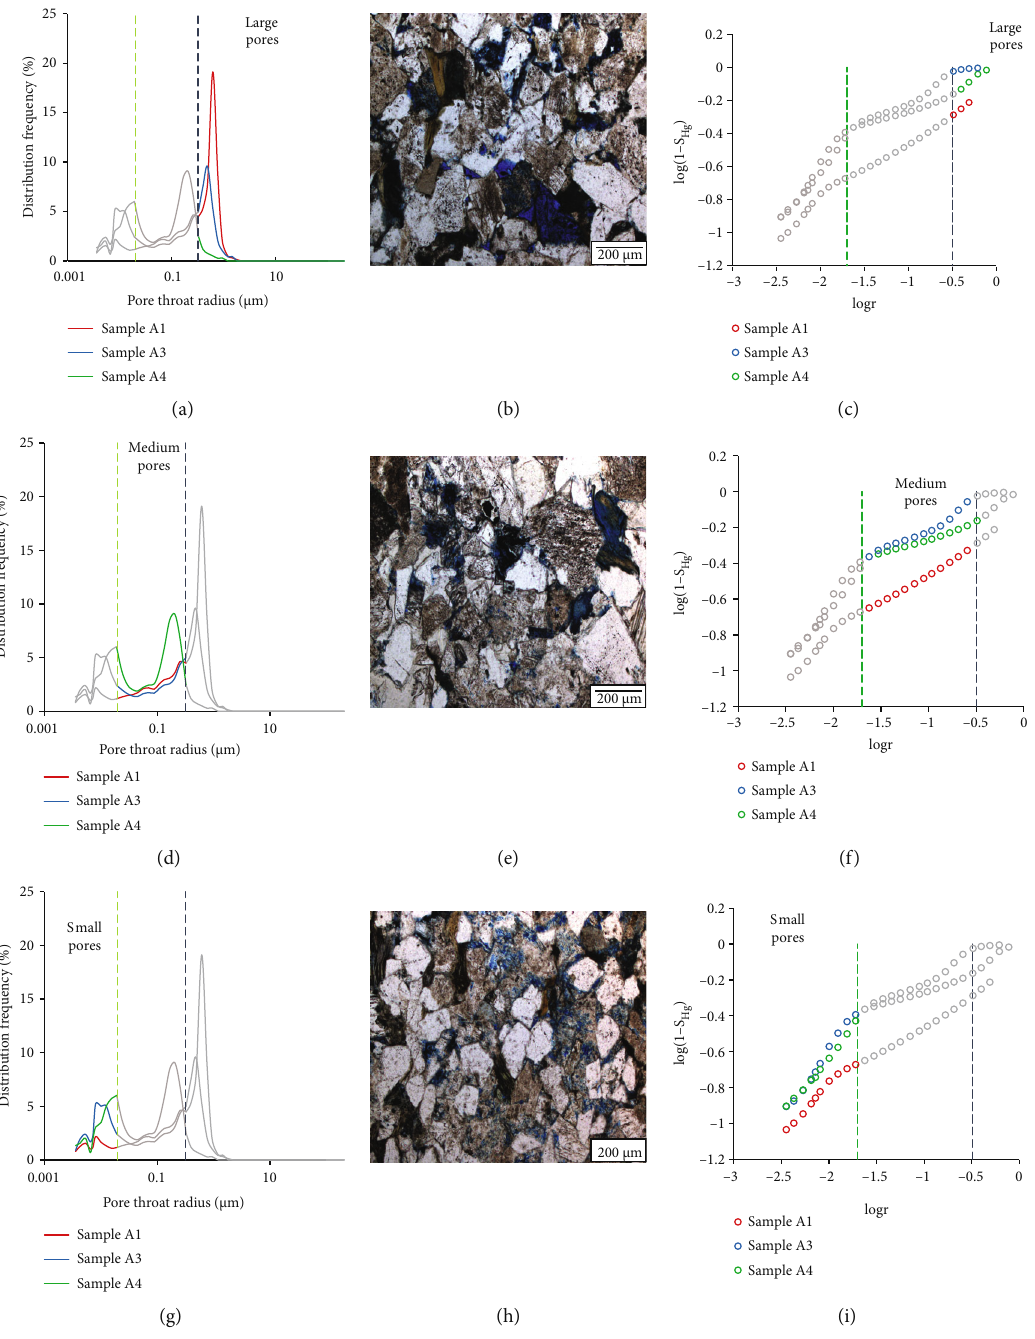
Figure 7: The pore-throat radius distribution curves of typical samples (a, d, g). The results of CTS of sample A1, A3, and A4 (b, e, h), respectively. The fractal curves of typical samples (c, f, i), and they are naturally divided into three parts by similar turning points. Table 4: The HPMI parameters of the typical